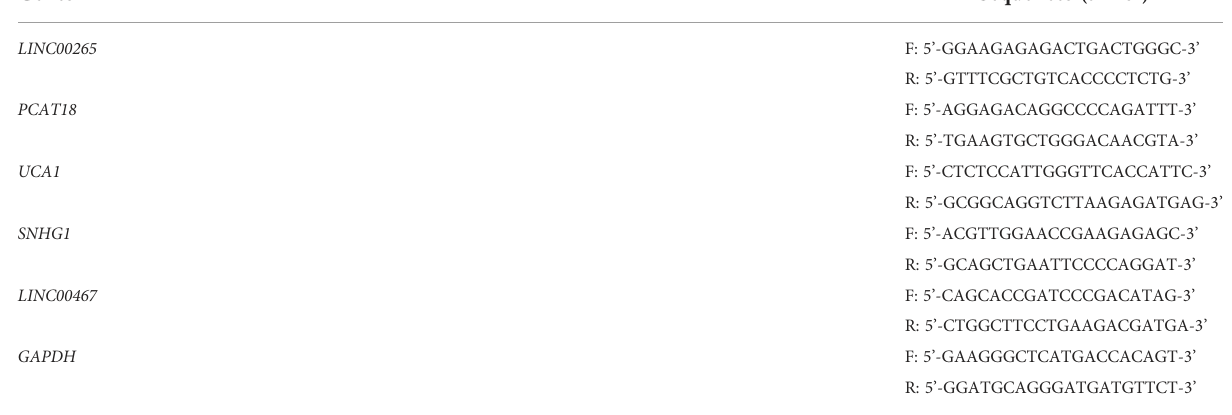
TABLE 2 The PCR primer sequences for each gene used in this study.